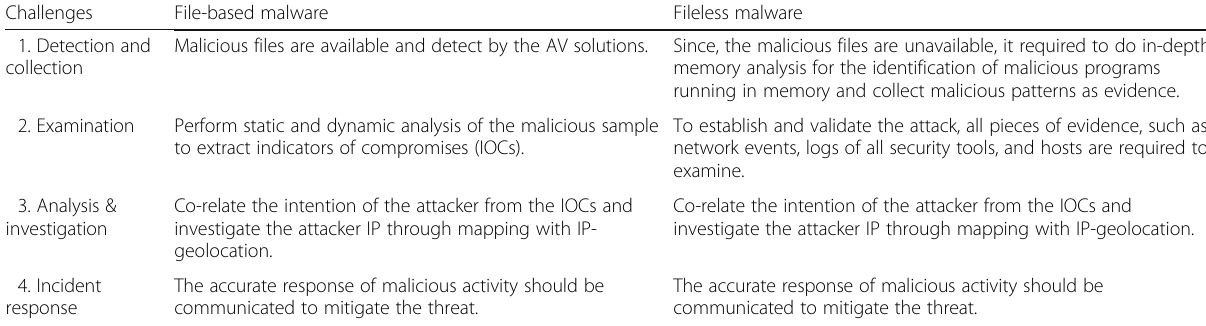
Table 5 Comparison of challenges between file-based and fileless malware Challenges File-based malware Fileless